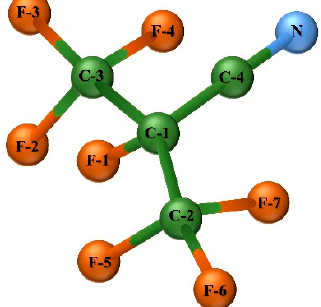
Figure 5. The molecule structure of C 4 F 7 N gas.